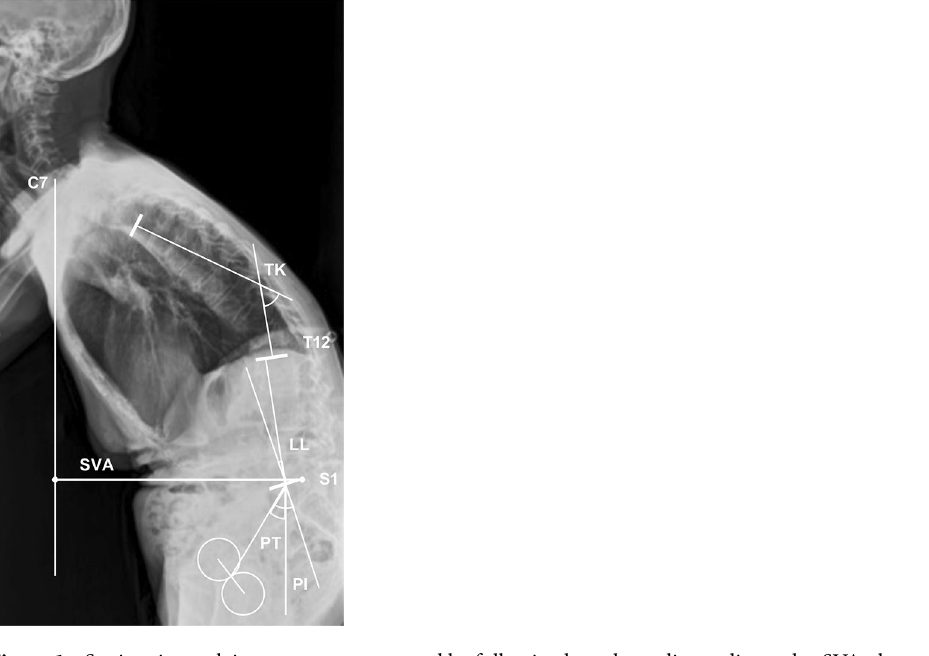
Figure 1. Static spino-pelvic parameters measured by full-spine lateral standing radiographs. SVA, the sagittal vertical axis; TK, thoracic kyphosis (T5-12); LL, lumbar lordosis (T12-S1); PT, pelvic tilt; PI, pelvic